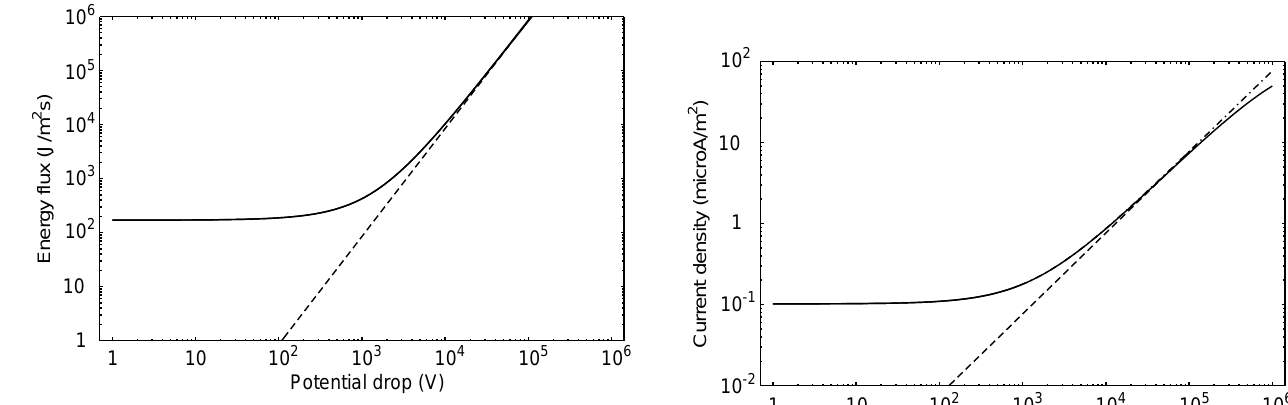
Fig. 2. Same as Fig. 1 but for the energy flux. In this case the first approximation ( dash ) is indistinguishable from the exact result ( solid ). The second approximation ( dot ) is still notably di(cid:128)erent for small energies